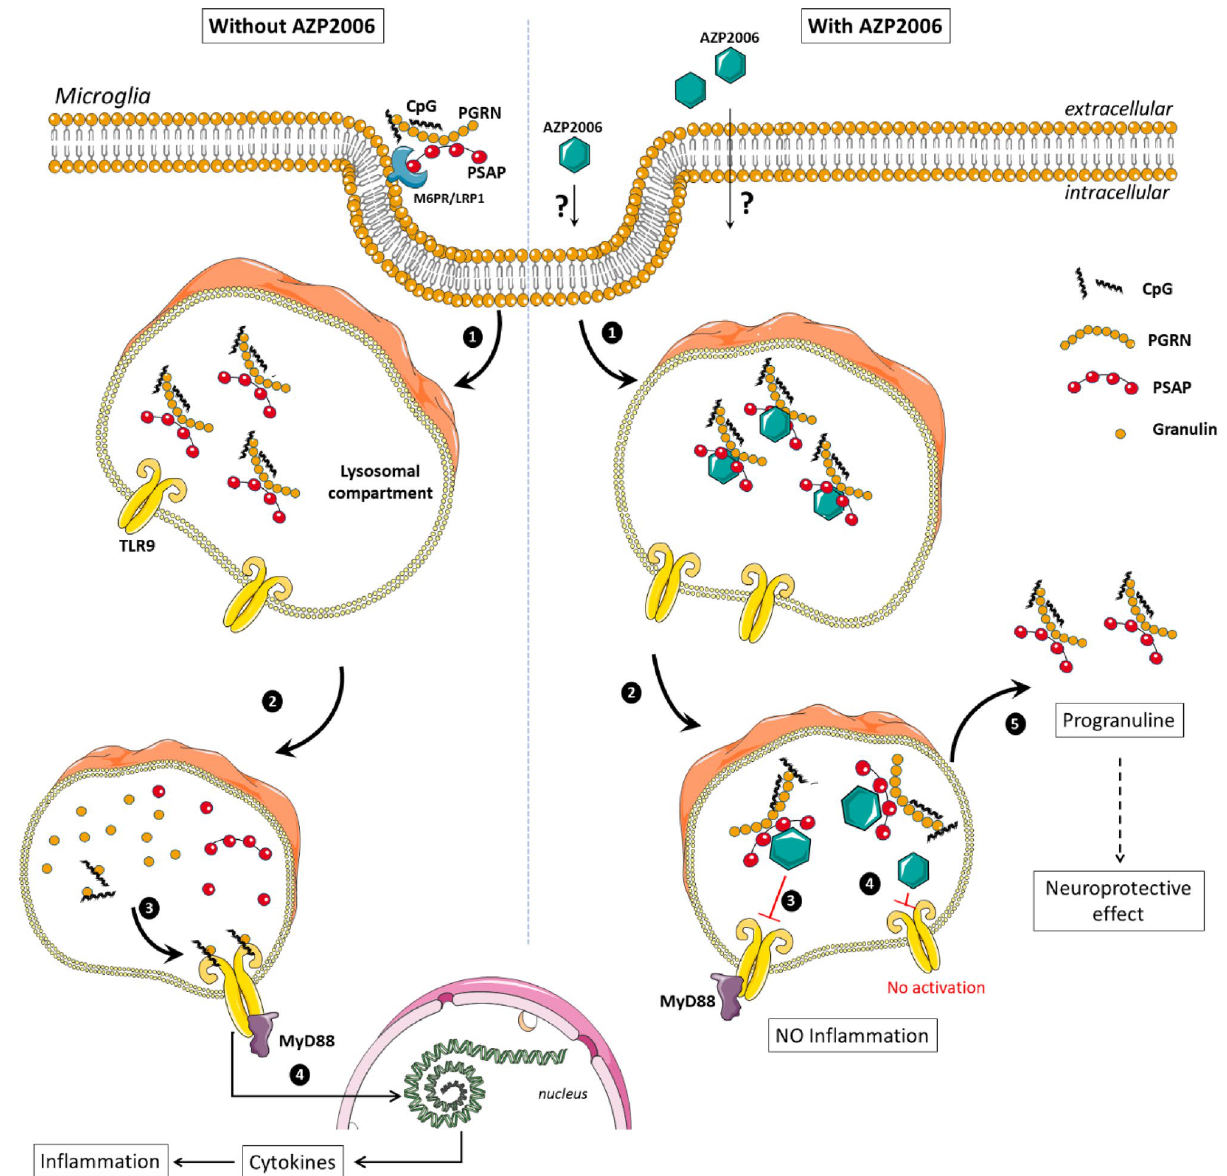
Figure 6. Hypothetical mode of action for AZP2006. Left panel: PGRN targeting is mainly found in microglial cells 44,45 . ( 1 ) PGRN may be associated with Prosaposin (PSAP) and be carried to endosomes as a passenger via the trafficking receptors M6PR/LRP1 45 . ( 2 , 3) PGRN complexed to PSAP are transferred to lysosomes where PGRN can be subject to protease cleavages that release individual granulin modules in the form of polypeptides of 6 kDa called granulins 78 . Granulin interacts with Toll-like receptor 9 (TLR9) and contribute to its activation 34 . ( 4 ) Once active, TLR9 triggers MyD88-dependent signaling that induces the production of pro- inflammatory cytokines after activation of NF-kB 79 . Right panel: In presence of AZP2006 ( 1 ) The mechanism used by AZP2006 to enter the cell is still unknown. However, its localization has been proved to be preferentially within the lysosomes. ( 2 ) In lysosomes, AZP2006 binds PGRN/PSAP and probably stabilizes the complex impeding PGRN release and cleavage. ( 3 ) The lack of granulins could be the cause of TLR9 inactivation. ( 4 ) In parallel, AZP2006 may act as TLR9 receptor direct antagonist, inhibiting its activity and then decreasing the proinflammatory pathway activation. ( 5 ) AZP2006, by preventing the processing of PGRN, can increase its release, which in turn could mediate the neuroprotective